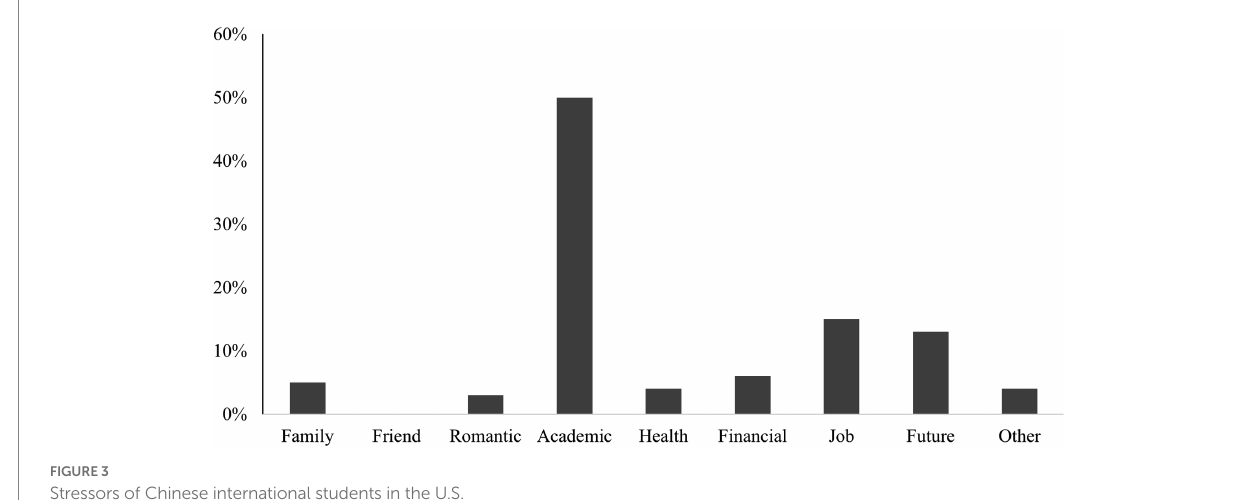
FIGURE 3 Stressors of Chinese international students in the